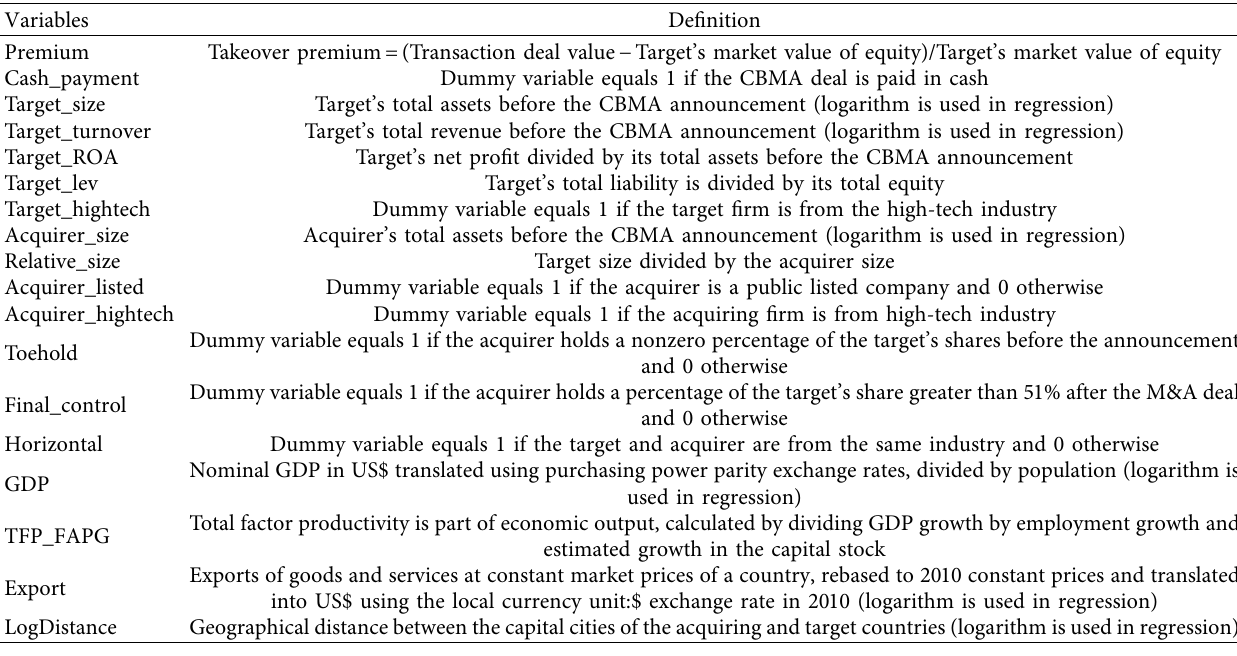
Table 1: Variables and